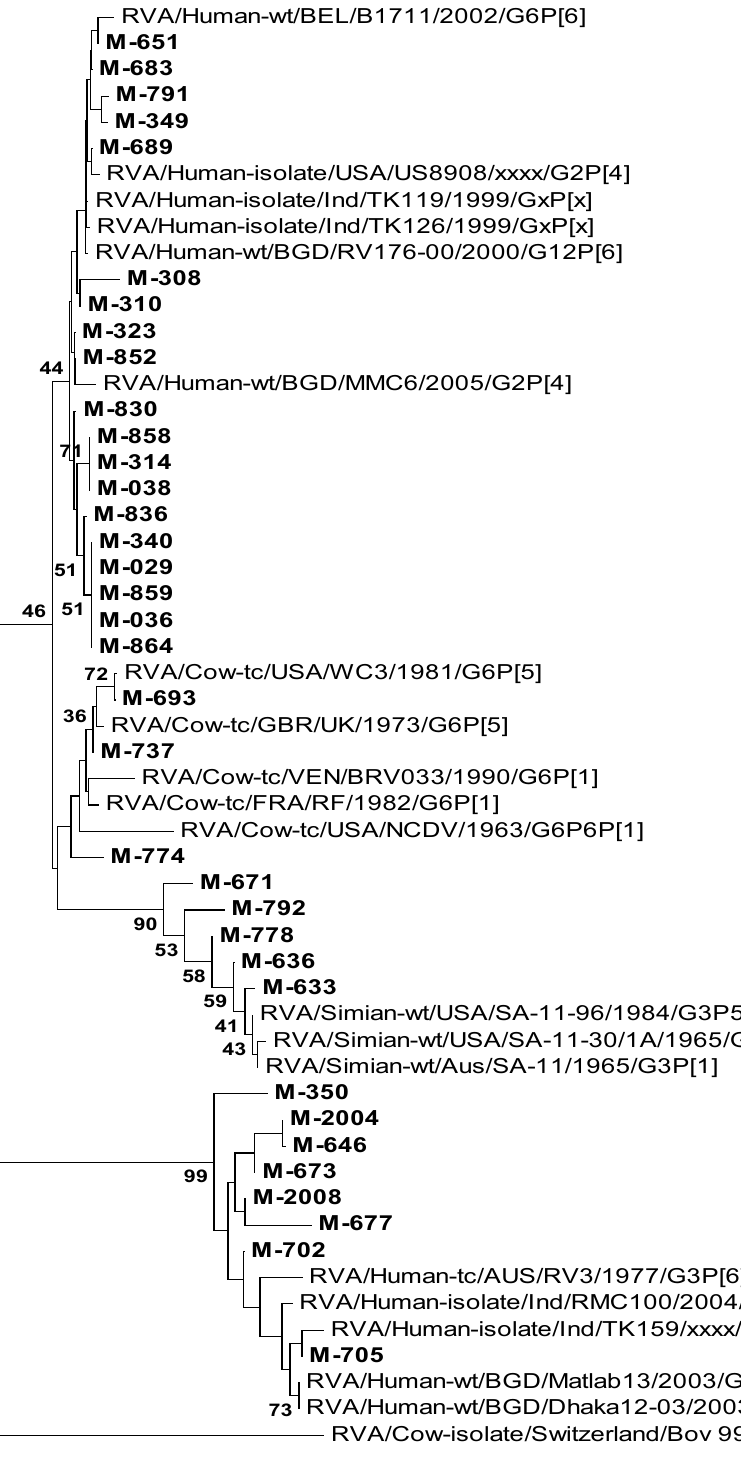
Figure 2. Phylogenetic tree based on the partial nucleotide sequences of VP6 gene (174 bp) of RVA strains. The strains of the present study are in bold face. Scale indicates genetic